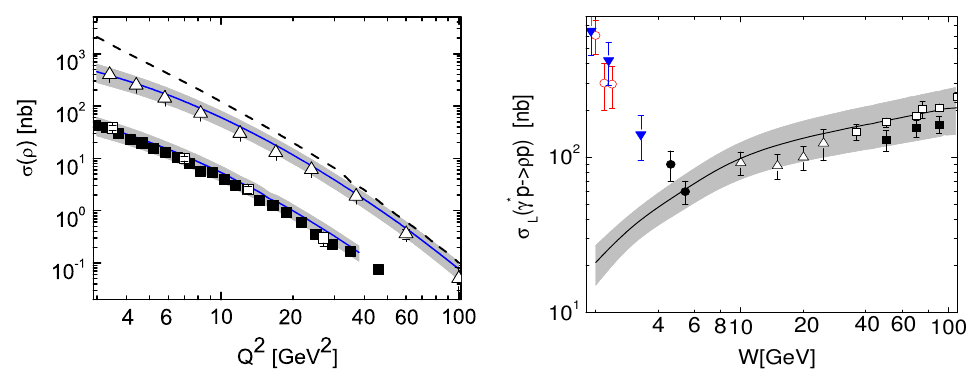
Figure 2. Left: The Q 2 dependence of the cross sections for the ρ production at W = 75 GeV / 10 and W = 90 GeV. The dashed line shows the leading twist results. Right: The longitudinal cross section for the ρ production at Q 2 = 4 . 0 GeV 2